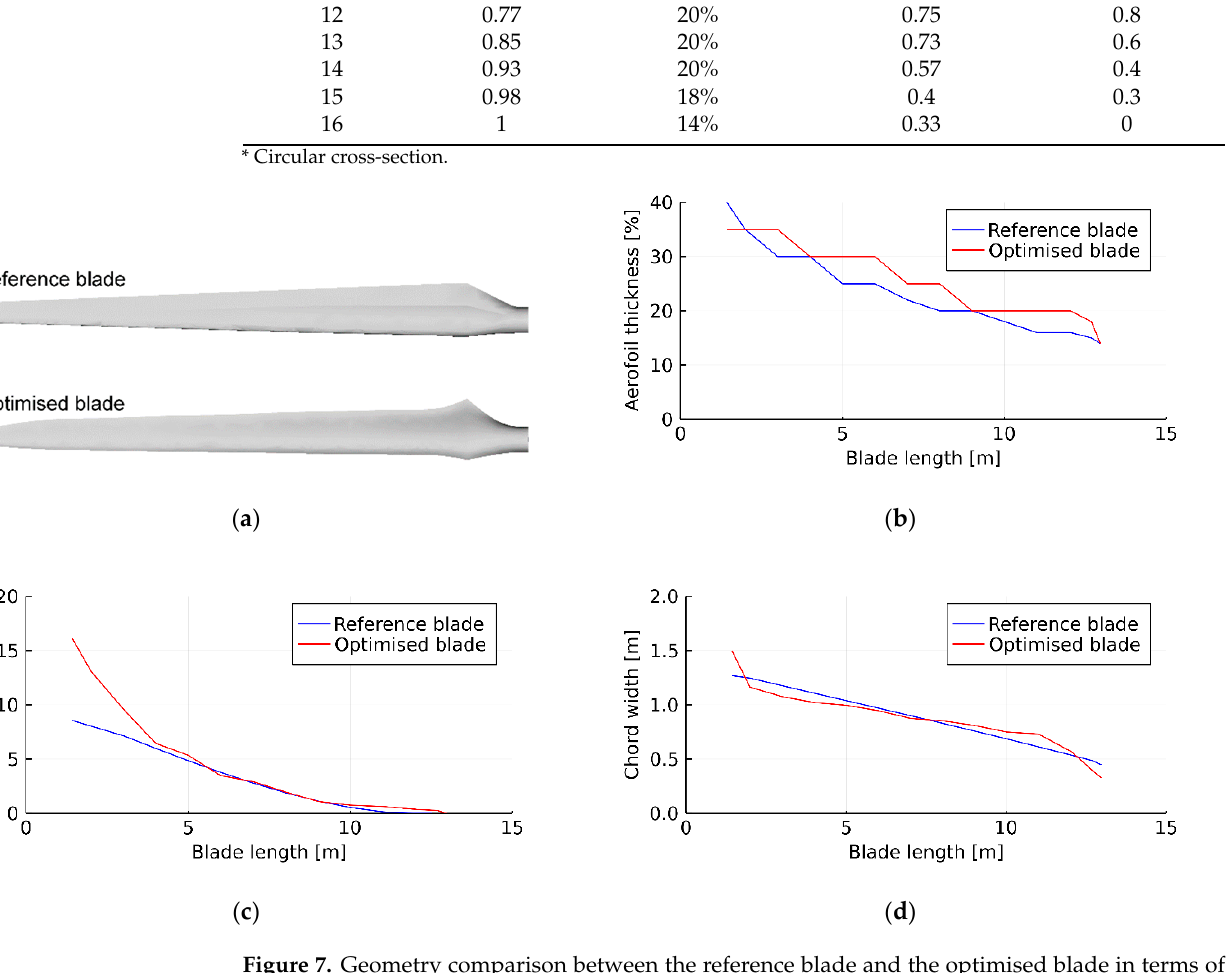
Figure 7. Geometry comparison between the reference blade and the optimised blade in terms of ( a ) blade shape, ( b ) airfoil thickness, ( c ) twist angle, and ( d ) chord